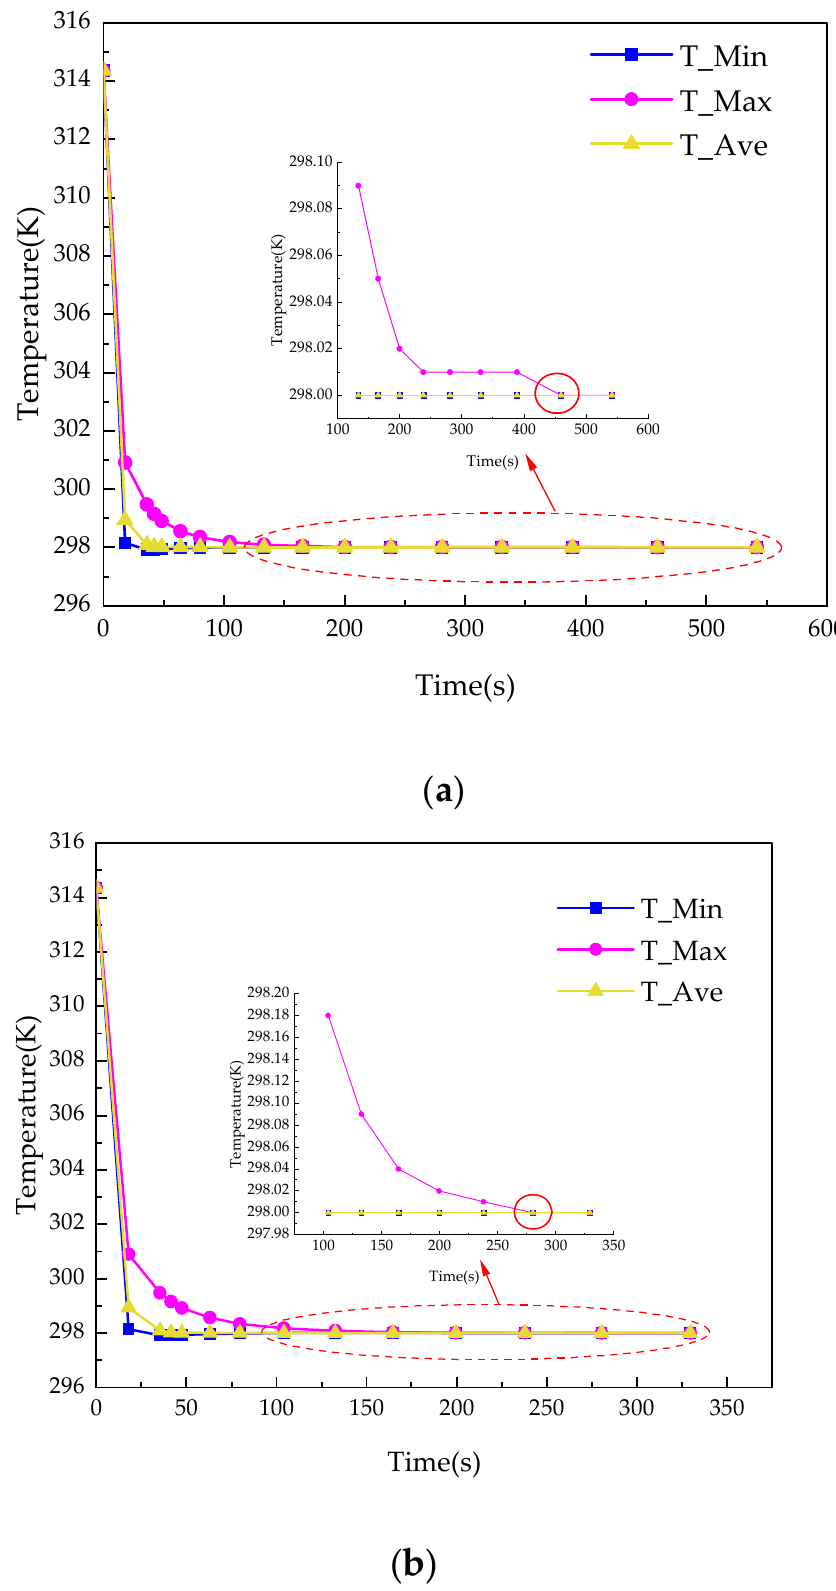
Figure 7. Comparison of cooling time between 8 mm and 10 mm. ( a ) 8 mm diameter cooling time. ( b ) 10 mm diameter cooling time.